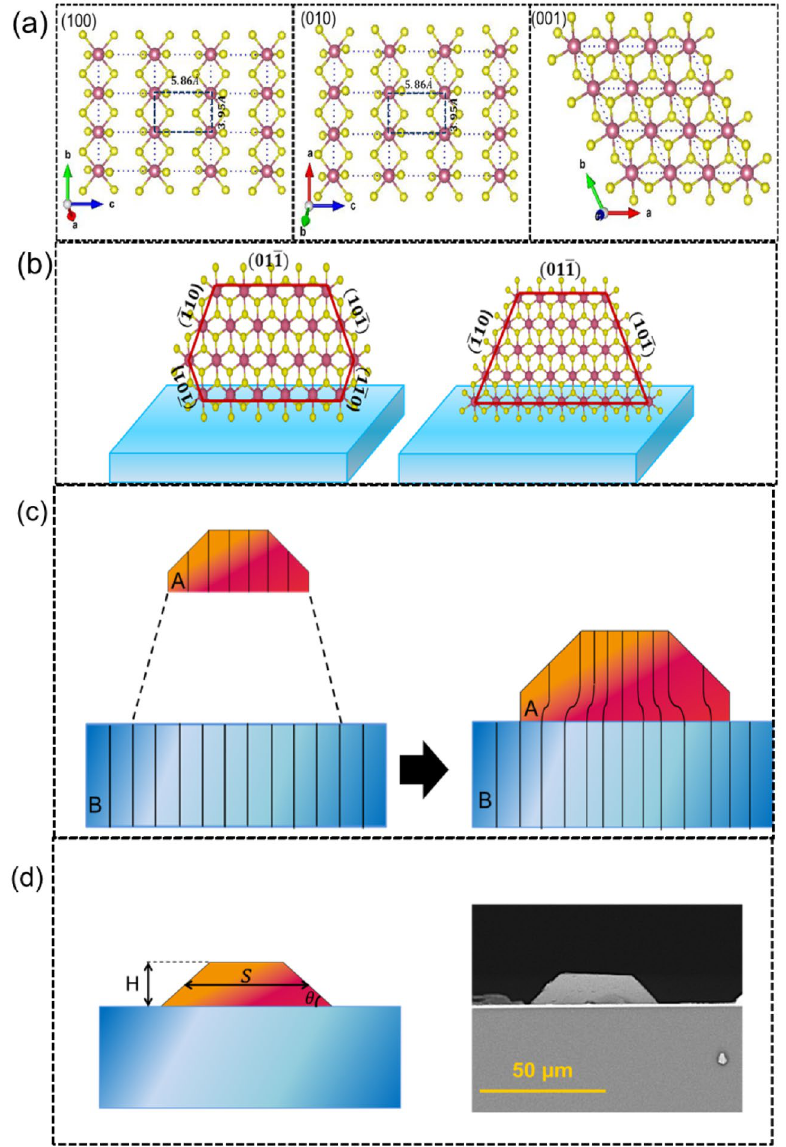
Figure 4. SnS 2 crystal growth mechanism. Schematic of ( a ) Crystal structure model in different (hkl), ( b ) Formation of grown vertically SnS 2 nanosheets with five and three crystal edges on the substrate ( c ) Pseudomorphic or coherently strained growth, to match the lattice constant of film (A) and substrate (B) 44 . ( d ) Schematic of grown polyhedral on the substrate with its parameters and FESEM analysis of the vertically grown SnS 2 nanosheet on